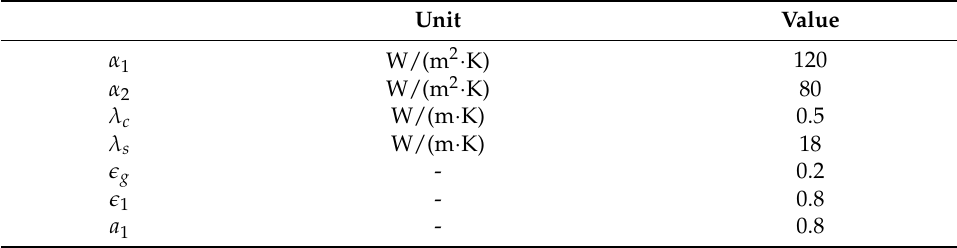
Table 2. Main parameters of the heat transfer.